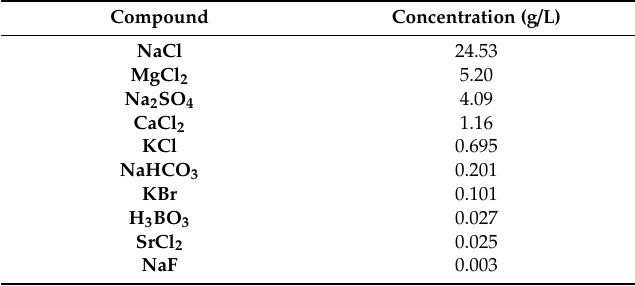
Table 2. Chemical composition of synthetic seawater used in this